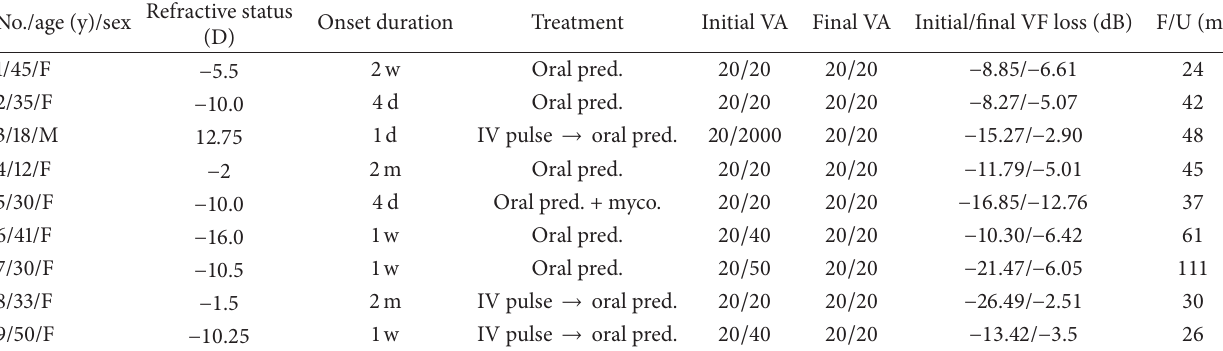
Table 1: Demographic data of